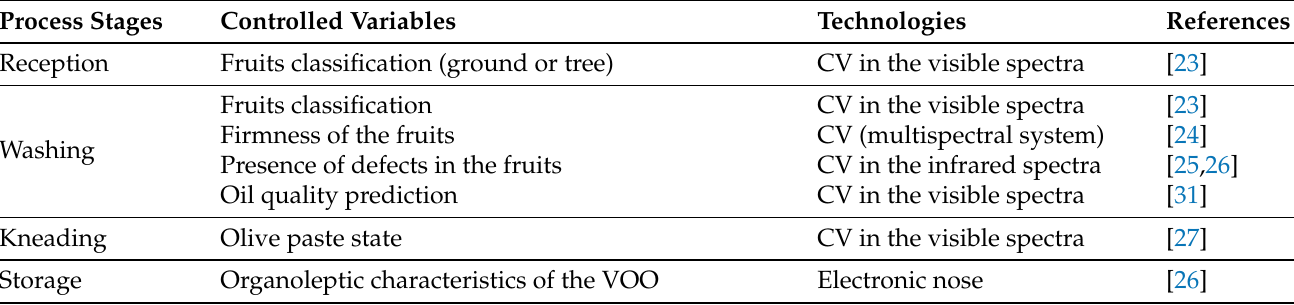
Table 1. Cutting-edge technologies in the VOO elaboration